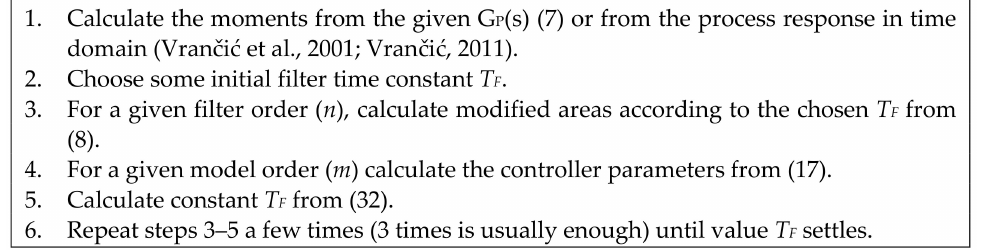
Figure 5. Calculation of the filter and controller parameters.